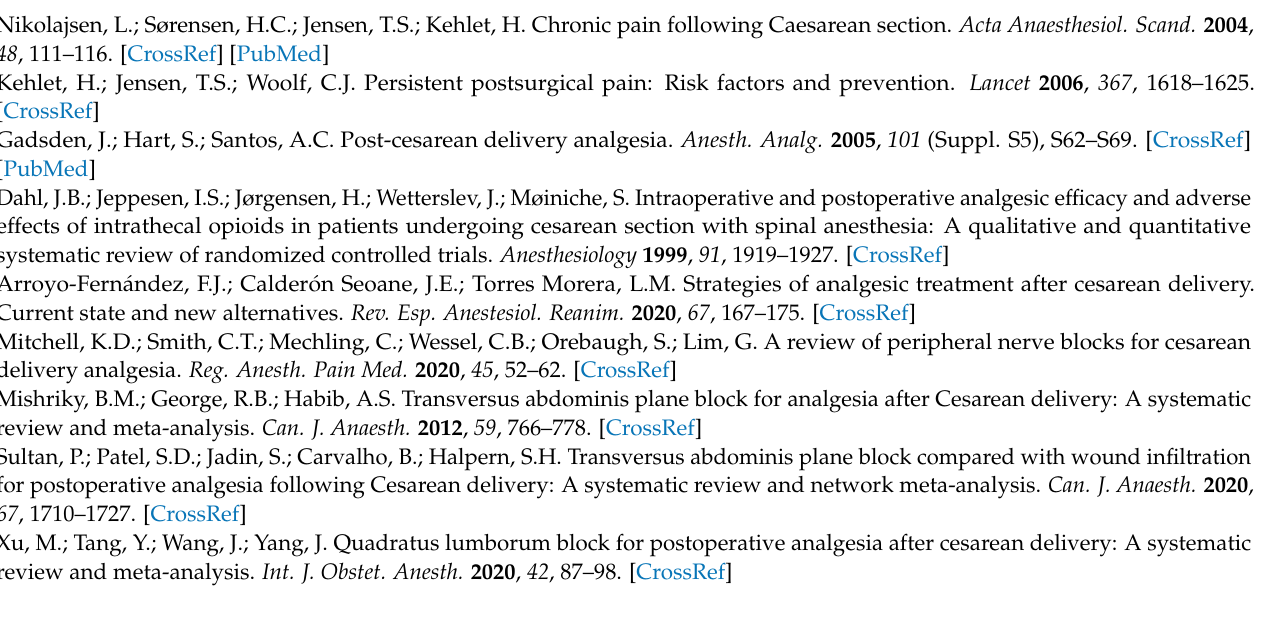
comparing with control in random effect model, (F) Node splitting plot in random effect model, and (G) Rankogram in random effect model); Figure S8: Dynamic pain at 6 h after surgery ((A) Trace plot and density plot in fixed effect model, (B) Trace plot and density plot in random effect model, (C) Gelman-Rubin-Brooks plot in fixed effect model, (D) Gelman-Rubin-Brooks plot in random effect model, (E) Forest plot comparing with control in random effect model, (F) Node splitting plot in random effect model, and (G) Rankogram in random effect model); Figure S9; Dynamic pain at 24 h after surgery ((A) Trace plot and density plot in fixed effect model, (B) Trace plot and density plot in random effect model, (C) Gelman-Rubin-Brooks plot in fixed effect model, (D) Gelman-Rubin-Brooks plot in random effect model, (E) Forest plot comparing with control in random effect model, (F) Node splitting plot in random effect model, and (G) Rankogram in random effect model); Figure S10: The time to first analgesic request ((A) Trace plot and density plot in fixed effect model, (B) Trace plot and density plot in random effect model, (C) Gelman-Rubin-Brooks plot in fixed effect model, (D) Gelman-Rubin-Brooks plot in random effect model, (E) Forest plot comparing with control in random effect model); Table S1: Summary of risk of bias assessment (RoB 2); Table S2: Network diagnostic for Bayesian analysis; Table S3: Network league tables for all the postcesarean analgesic strategies regarding ((A) Pain at 6 h after surgery and (B) Postoperative cumulative 24 h morphine equivalent consumption); Supplementary Materials-Methods (S1: Materials and Methods; S2: